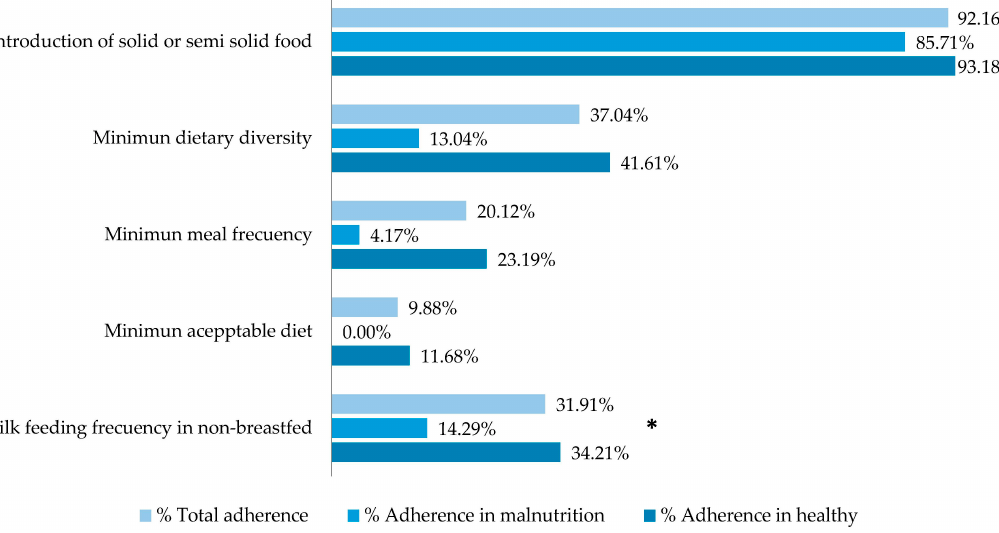
Figure 5. Indicators of adherence to complementary feeding practices (WHO 2008): prevalence in the total group, in children with wasting, and in healthy children. Footnote: Wasting is defined as W/L < − 2 SD according to the WHO 2006 standard. * p < 0.05 test Chi 2 test.